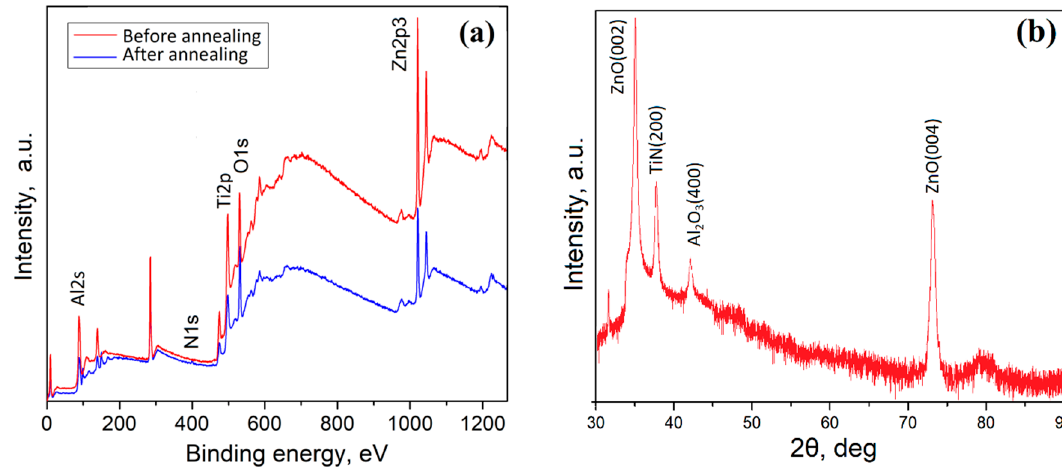
Figure 3. XPS ( a ) and XRD ( b ) spectra of the nanocrystalline ZnO film.